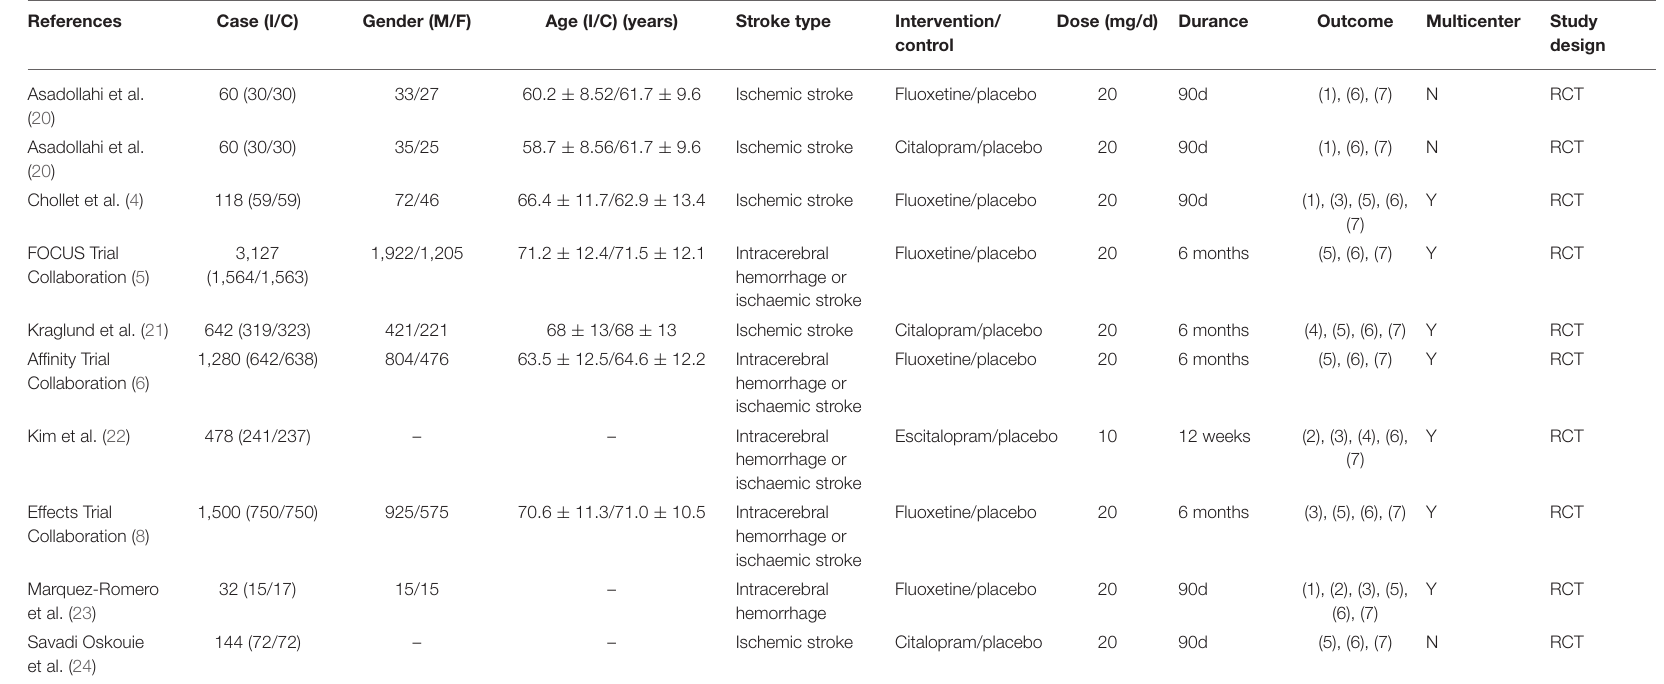
TABLE 1 | The characteristics of included RCTs in the